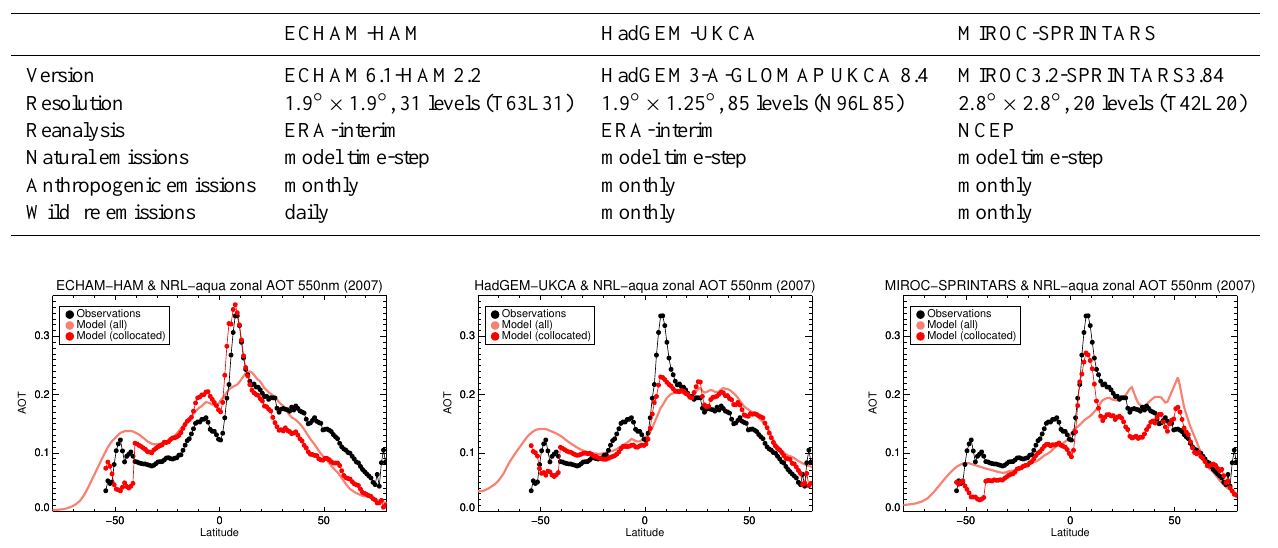
Table 1. Models used in this study.